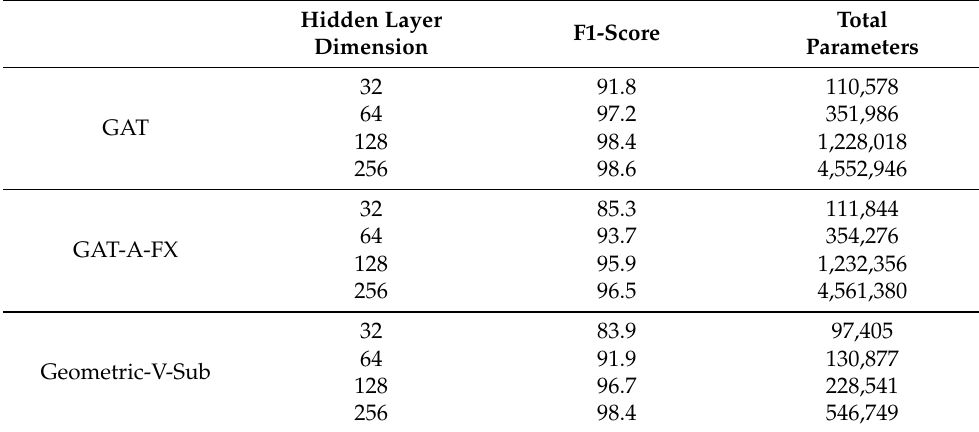
Table 4. Accuracy comparison and parameter comparison in inductive